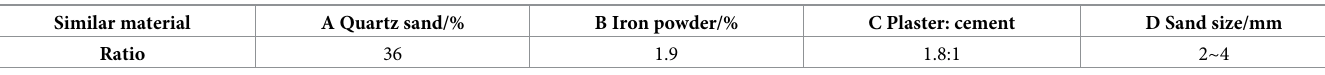
Table 6. Multiple linear regression was used to determine the ratio of similar materials.